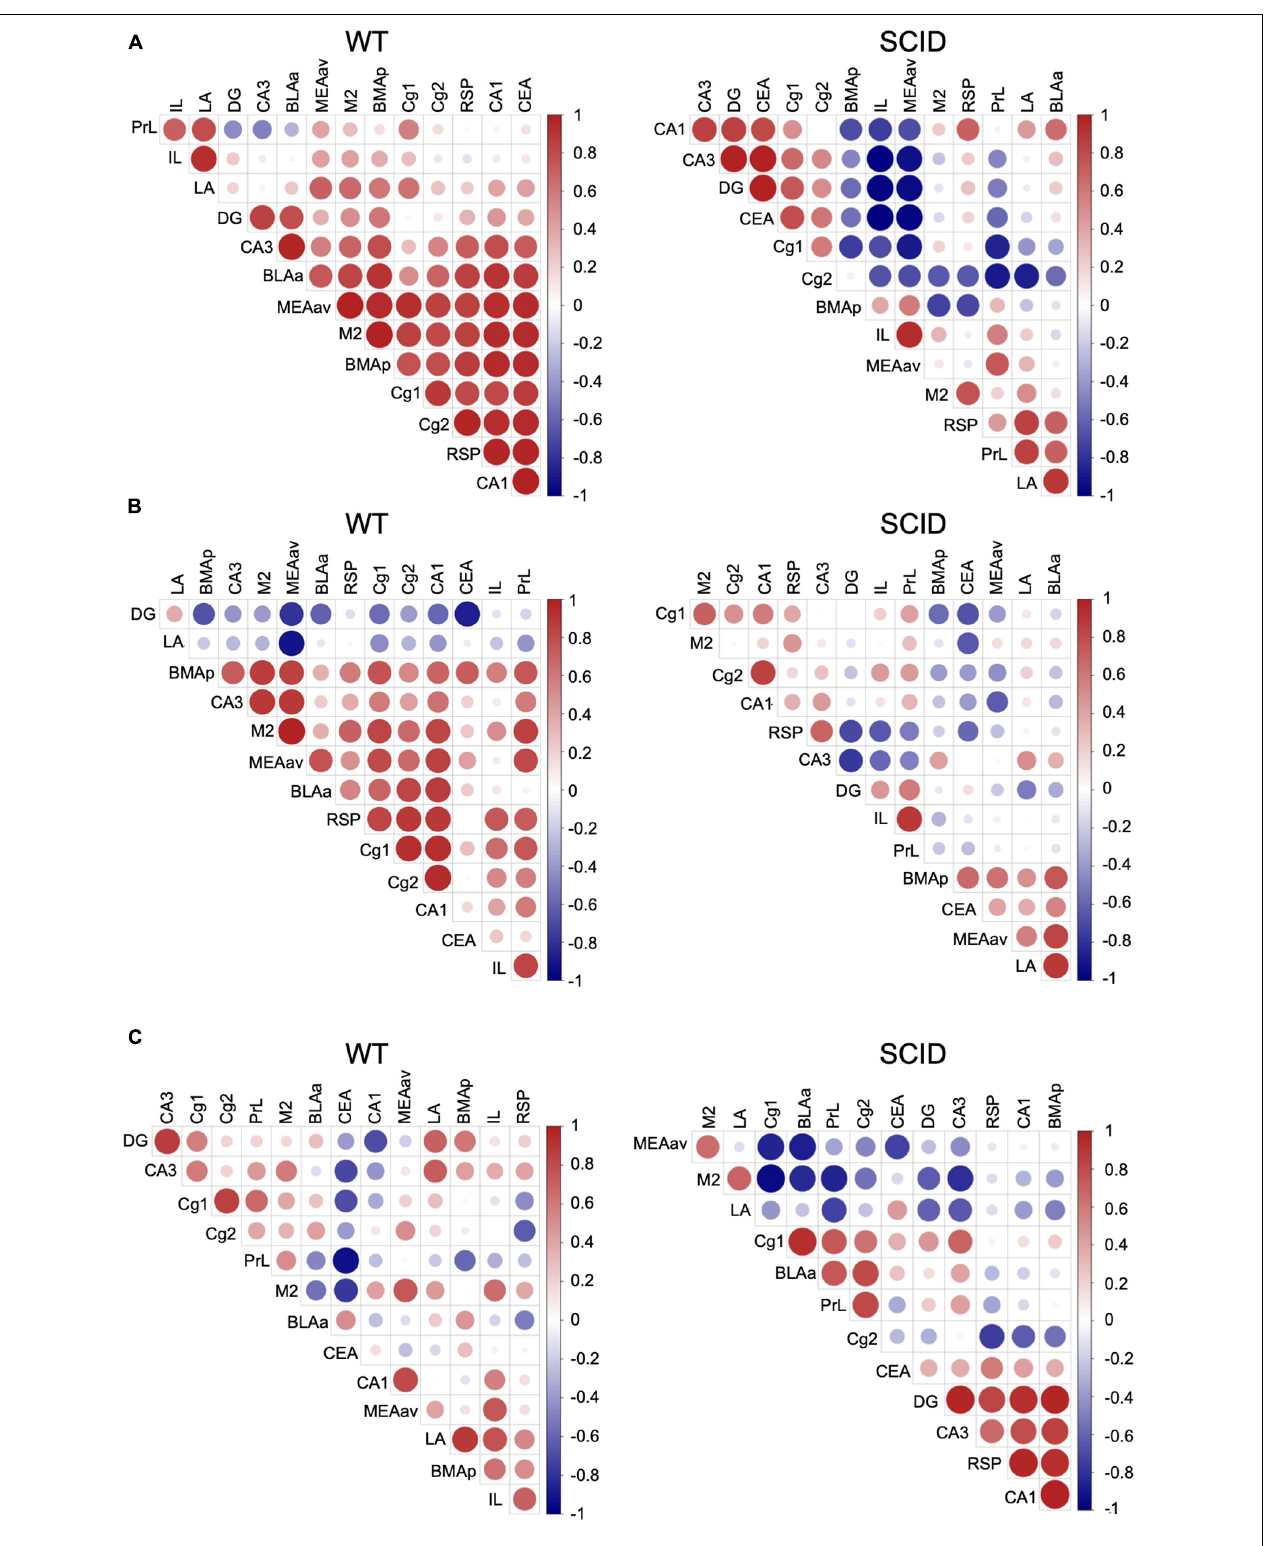
FIGURE 4 | Variations in interregional correlation of c-Fos activation between WT and SCID mice. Pearson correlation matrices showing interregional correlations of c-Fos activation density. Axes represent the brain regions. The different colors represent Pearson correlation coefficients (scale, right). Panel (A) is for WT and SCID mice after the CFC training. Panel (B) represents WT and SCID mice after recent retrieval. Panel (C) represents WT and SCID mice after remote retrieval.